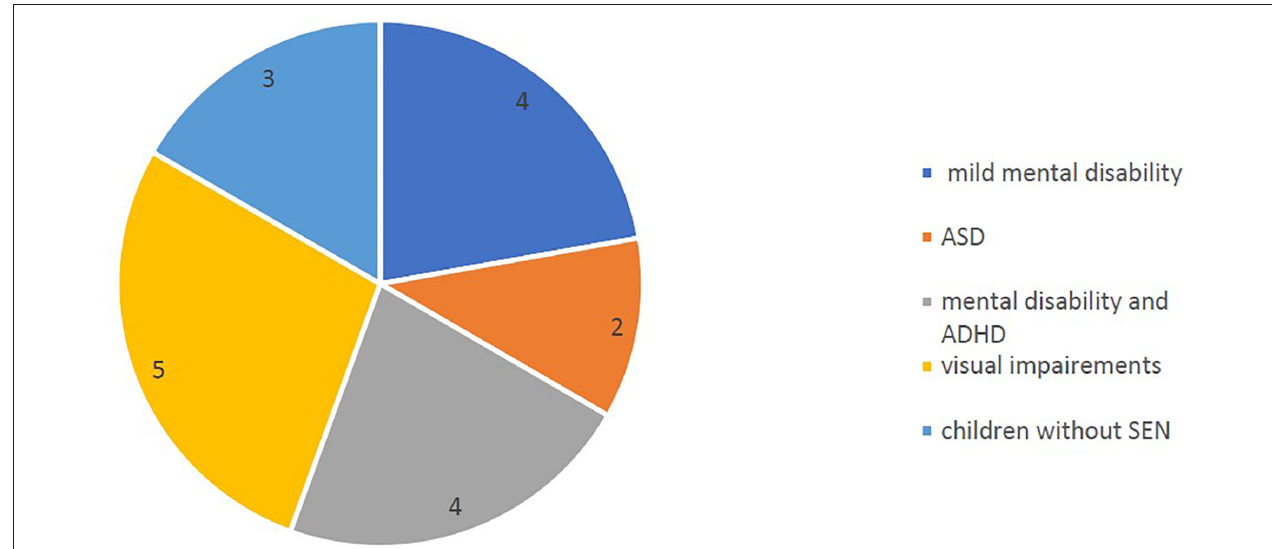
FIGURE 3 | Categories of students